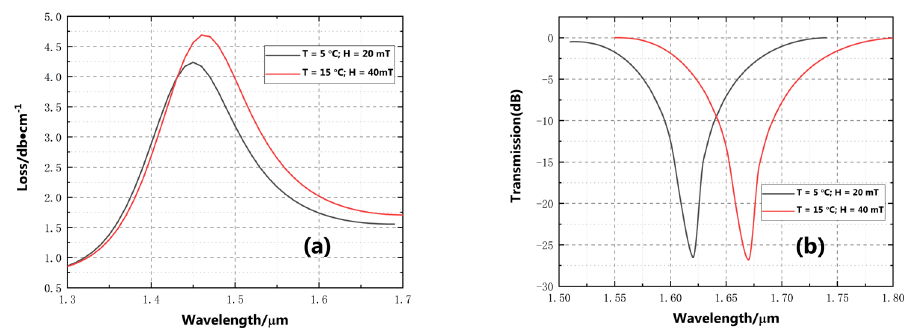
Figure 10. The loss spectra ( a ) and transmission spectra ( b ) of the sensor in two different scenarios (5 °C/20 mT and 15 °C/40 mT).